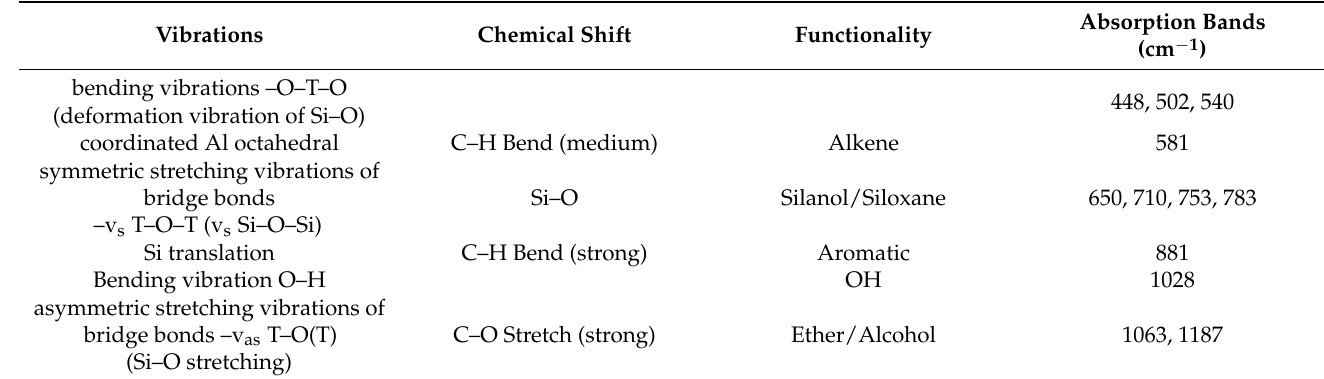
Figure 4. FT-IR spectra of raw corn stover ash (as received). Table 1. IR vibrational frequencies of corn stover ash.